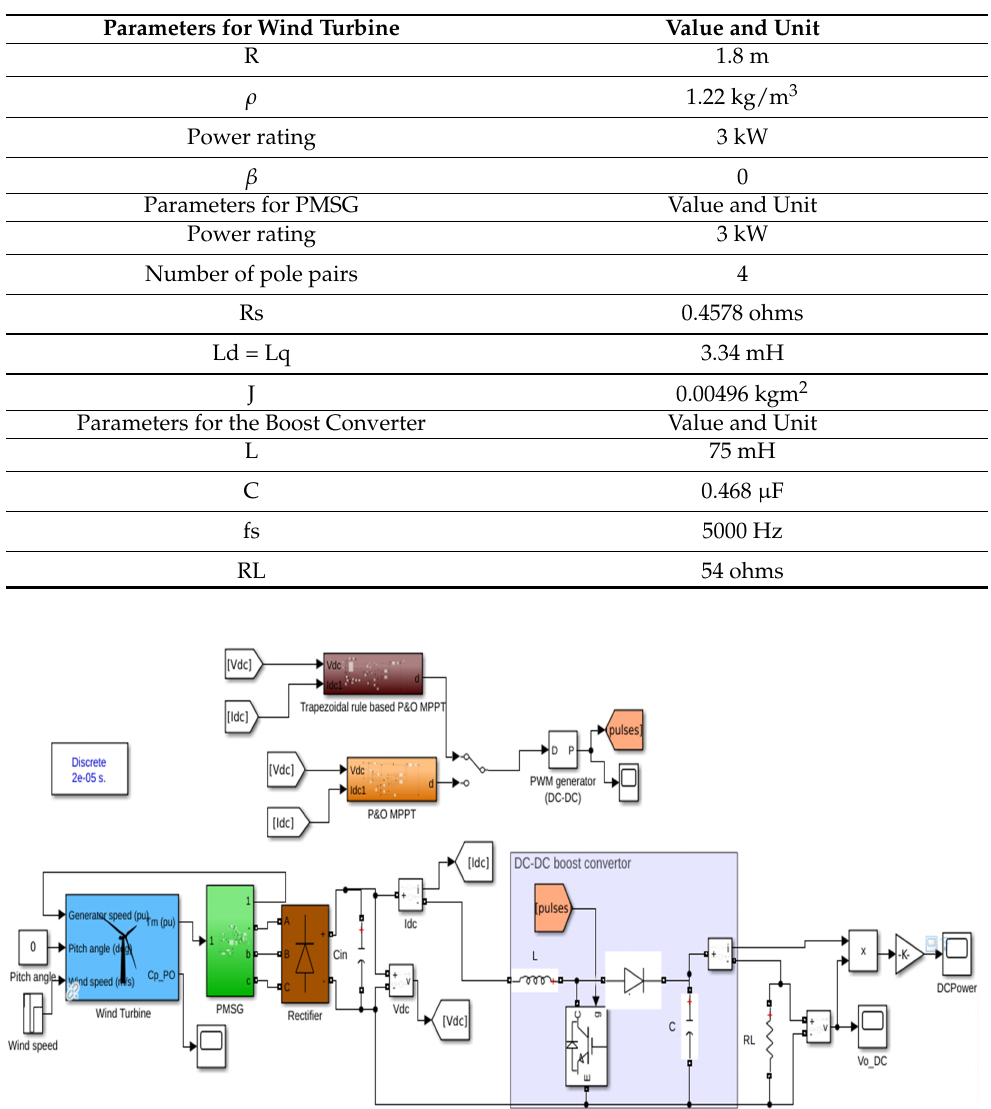
Figure 11. SIMULINK model for the proposed algorithm and P&O